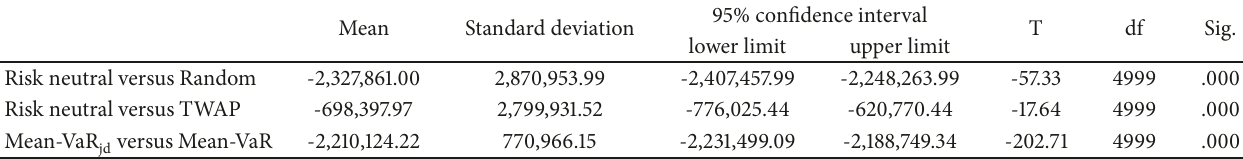
Table 3: Optimal trading